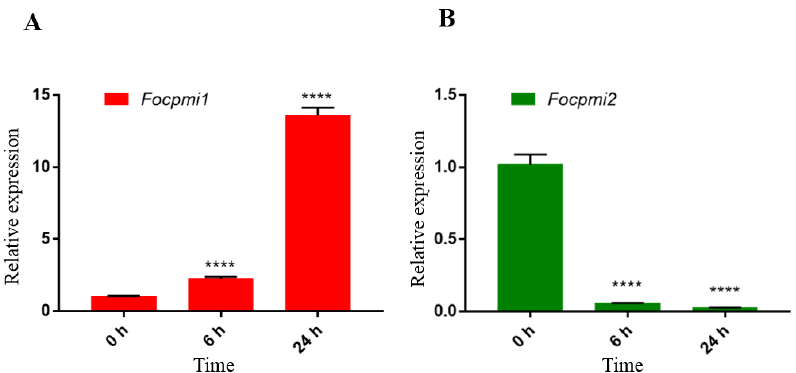
Figure 1. The qRT-PCR expression analysis of Focpmi1 and Focpmi2 at conidial (0 h), germination (6 h), and mycelium (24 h) stages cultured in YPD medium. The constitutive FocEF1α was used as an internal reference gene and the 0 h stage was used as a control. ( A ) Focpmi1 expression at different growth stages. ( B ) Focpmi2 expression at different growth stages. The data are presented as means (±SEM) based on three independent experiments. Asterisks indicate significant differences from the control group (Student’s t -test, **** p < 0.0001).